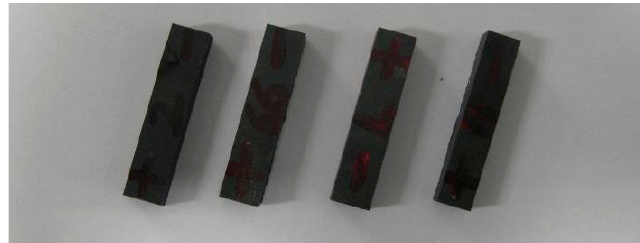
Figure 2. Segmented C/SiC composite specimen.